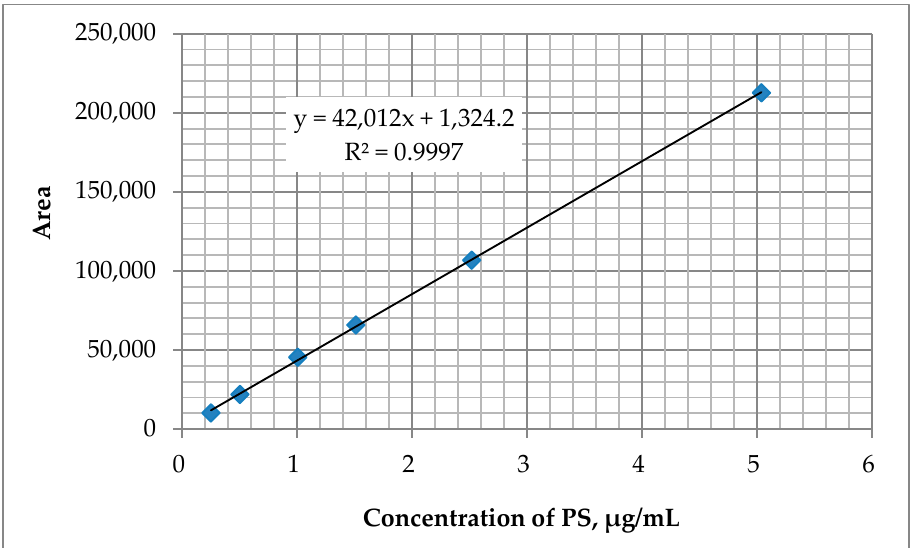
Figure 3. A graph of PS peak area dependence on its concentration in the standard solutions. GC ‐ MS, HP ‐ 5MS column, programmable column temperature.